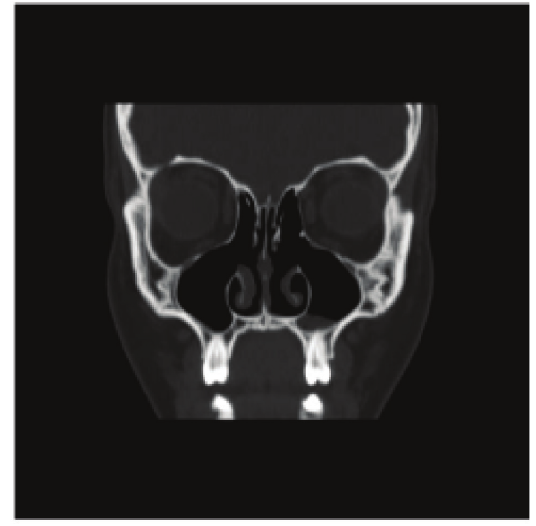
Figure 1. Non-contrasted coronal CT scan from two years prior to patient presentation. Only mild mucosal thickening of the floor of the left maxillary sinus and post-surgical changes related to endoscopic sinus surgery were noted.